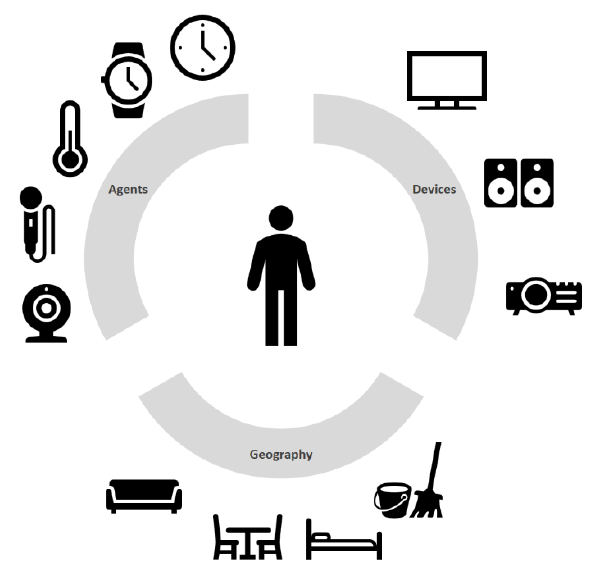
Figure 2. Entities of a home.